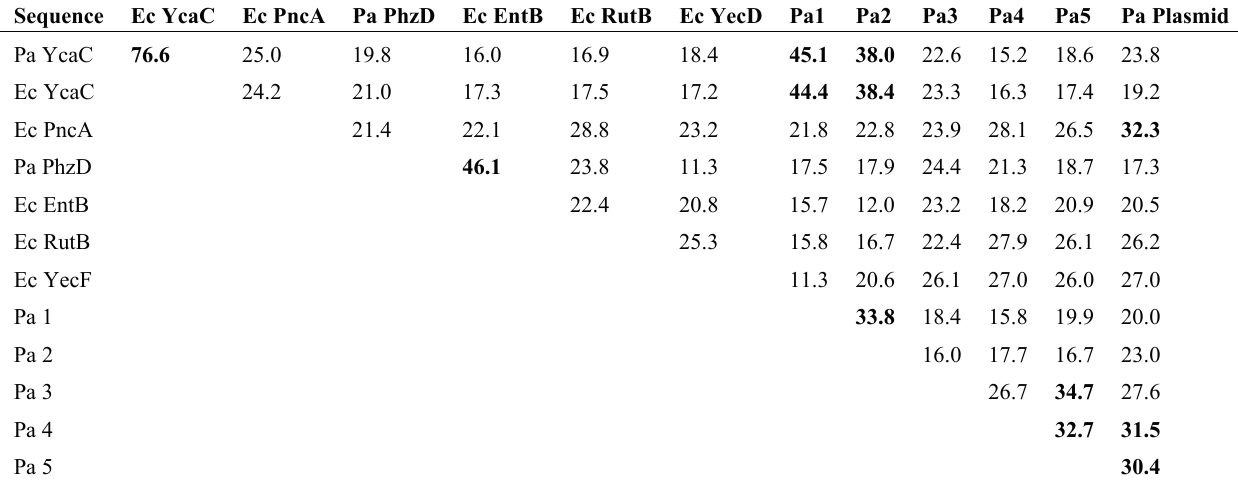
Table 2. Sequence identity matrix of YcaC and paralogues in P. aeruginosa (Pa) and E. coli . (Ec). PncA is a nicotinamide hydrolase; PhzD and EntB are isochorismatases; RutB is a peroxyureidoacrylate/ureidoacrylate amidohydrolase; YecD, like YcaC, is of unknown function. Pa1–5 are P. aeruginosa paralogues of YcaC; Pa2 is found in strain PA7, but not in PAO1. The Pa plasmid is an isochorismatase family protein found on a virulence plasmid that confers antibiotic and heavy-metal resistance, isolated from a clinical strain